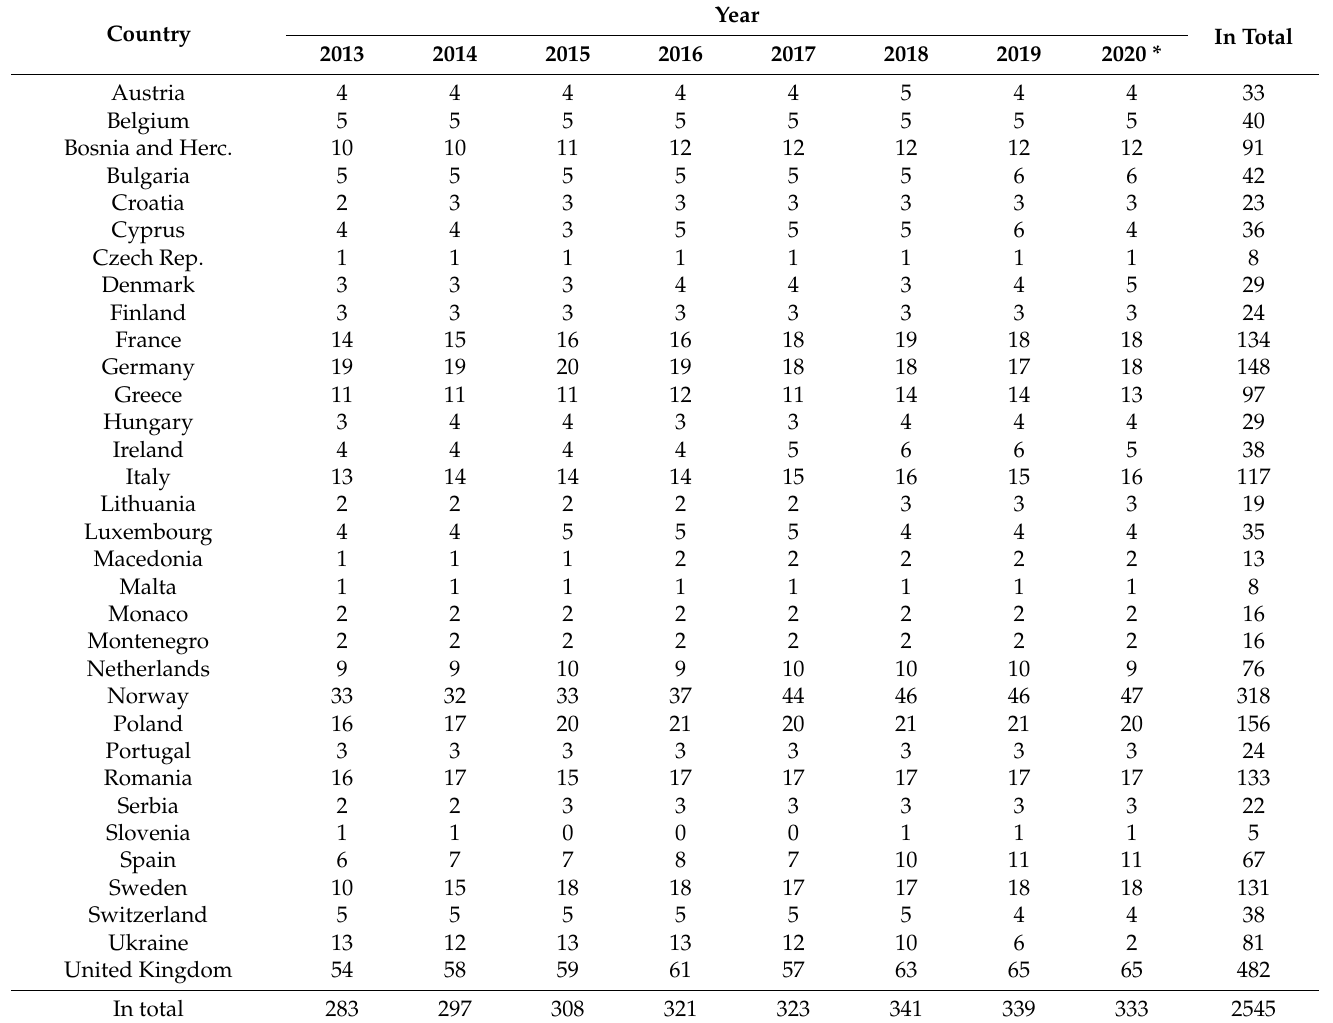
Table 1. Sample composition—cross country and time